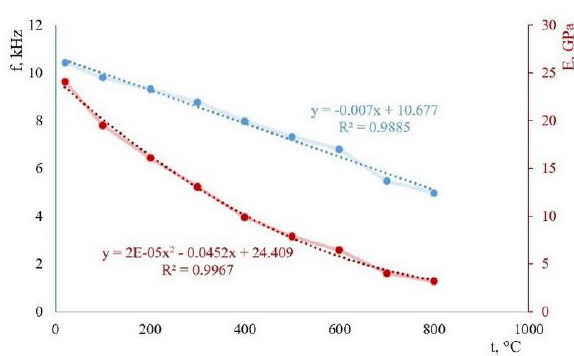
Figure 5: Plots of the dependence of the shock echo method reso- nant wave frequency and concrete elasticity index on the tempera- ture in fire simulation. ( Source: authors’ elaboration